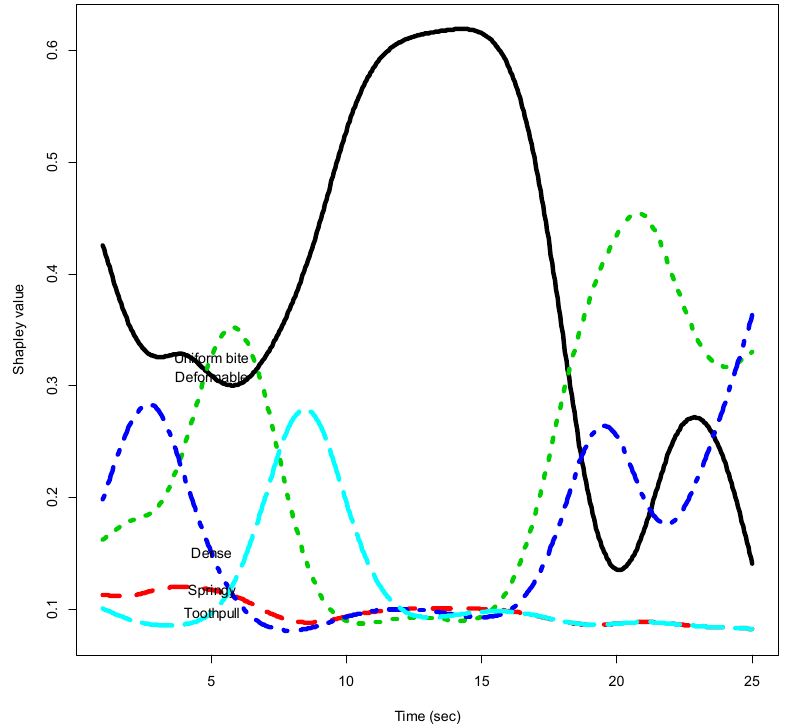
Figure 8. Temporal drivers of Overall Liking of Texture with CATA scale (5 CATA items in the first bite) .